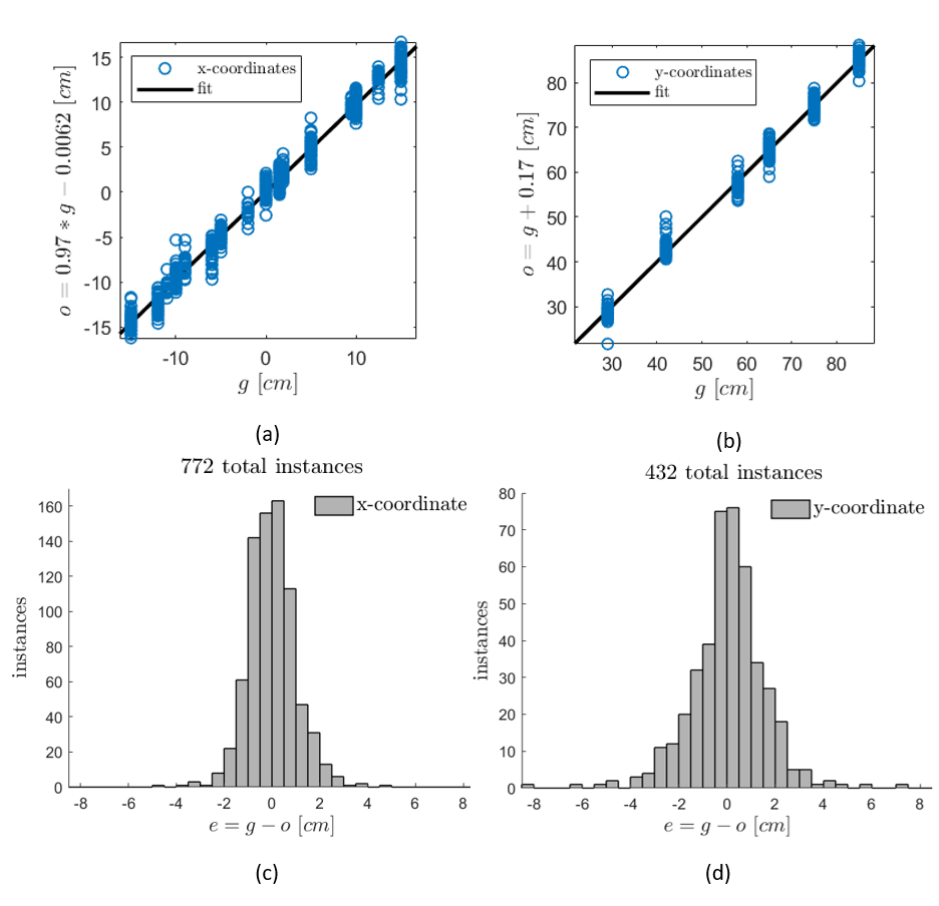
Figure 7. Results of the NNs predictions of ( x , y ) coordinates of different cylinder locations using the input samples of the training dataset. ( a , b ) predicted outputs of ( x , y ) as a linear fitted function of their labeled targets. ( c , d ) histogram plots of the prediction error instances resulted from both